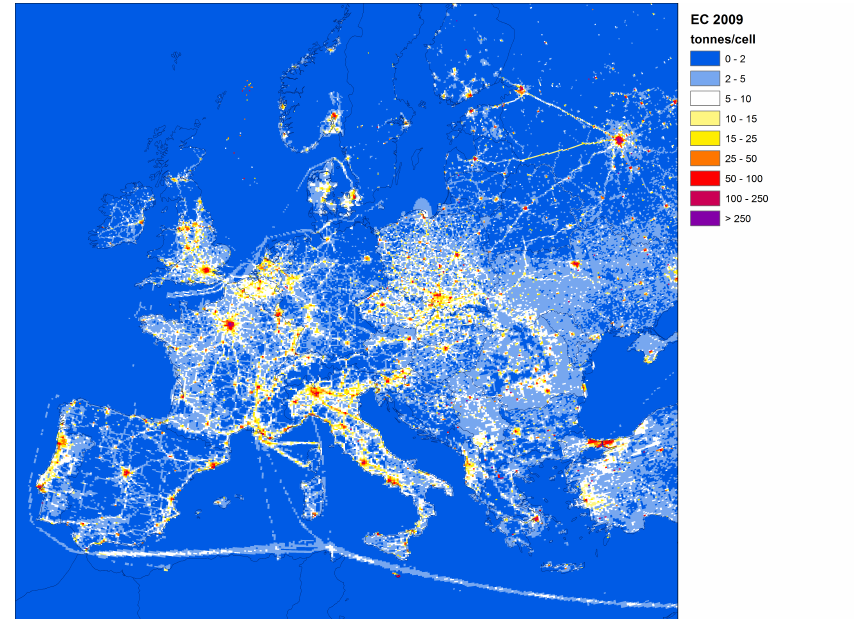
Figure 9. Spatially distributed EC emissions (fine mode) from the year 2009 for all